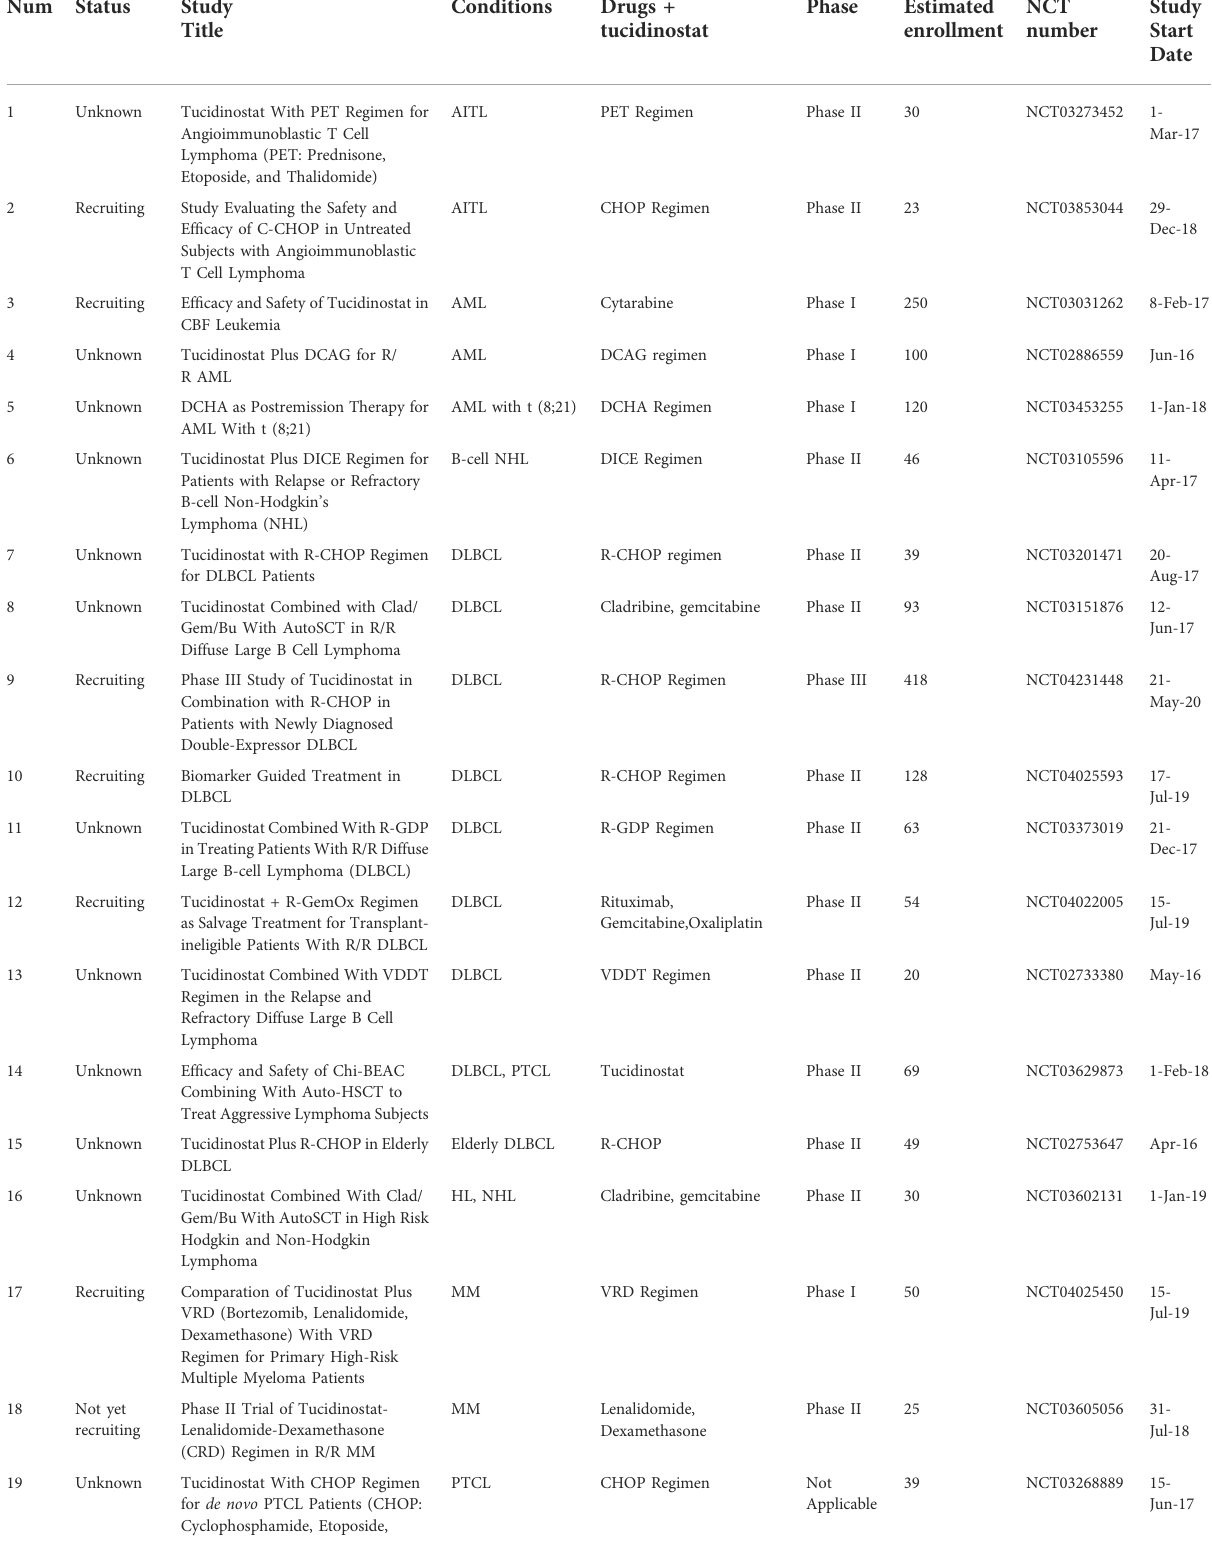
TABLE 3 Ongoing clinical trials of tucidinostat in combination with